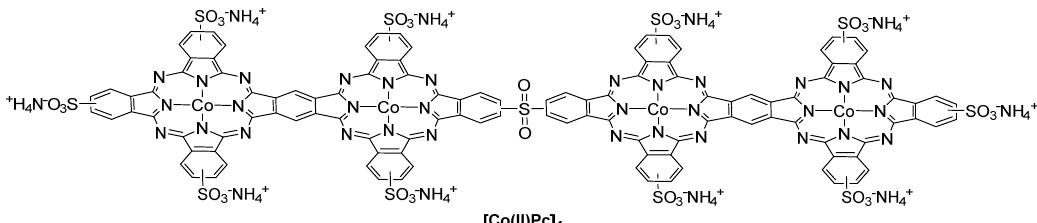
Figure 19. Co(II) phthalocyanine tetramer (Co(II)Pc) 4 used for the preparation of organic-inorganic polyoxometalate (POM) hybrids (I ) and (II) through controlling the molar ratio of precursors ((Co(II)Pc) 4 : PMoV ) (adapted from [67]).